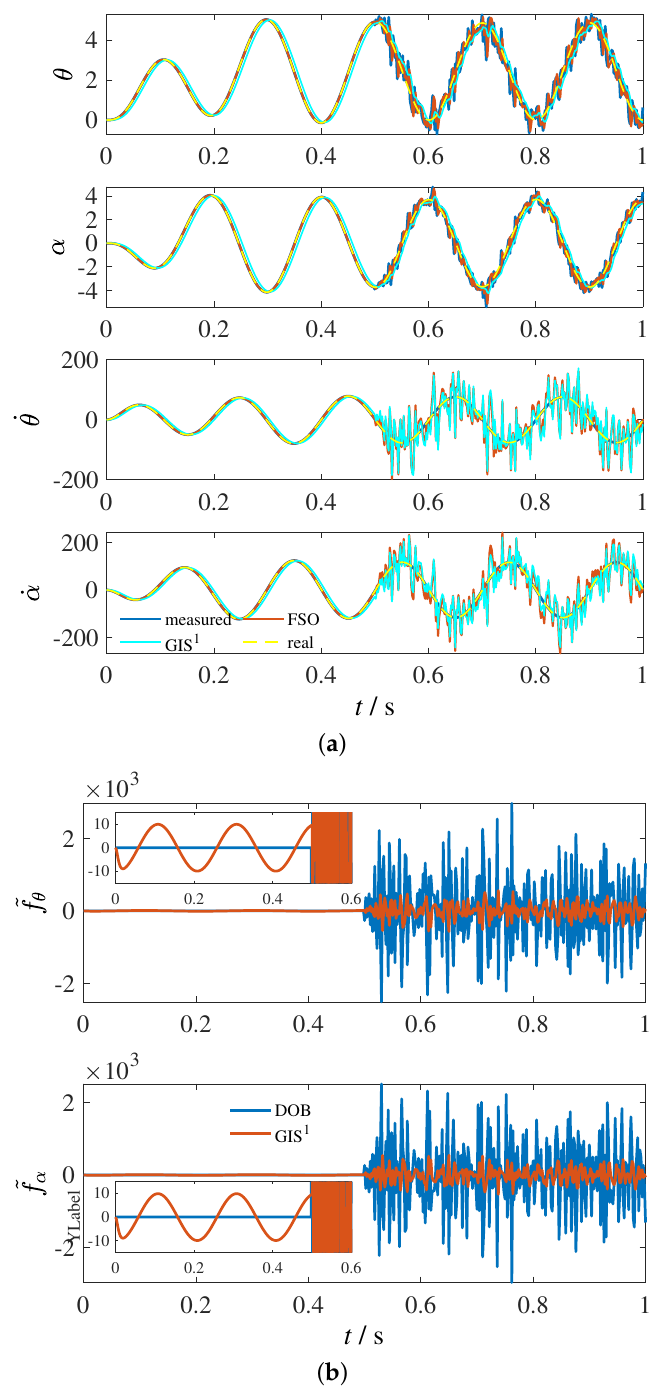
Figure 4. Estimated states of model-based observers: ( a ) derivatives; ( b ) disturbances. Figure 5a,b showthe results of the model-free methods; that is, GIS 2 , HGO 1 , HGO 2 , and ESO. None of these methods utilized information from the model in the design process, and they all had the same design bandwidth. It can be seen that GIS 2 still presented the best overall performance for the same bandwidth. More interestingly, HGO 1 and GIS 2 showed the same noise suppression performance when estimating θ and α , while HGO 1 performed poorly when estimating ˙ θ and ˙ α . In contrast, HGO 2 had the same noise suppression performance as GIS 2 when estimating ˙ θ and ˙ α , but performed poorly when estimating θ and α . The noise suppression performance of ESO for each variable was